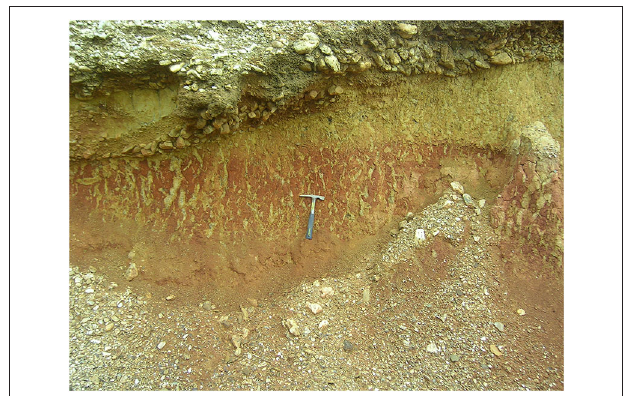
FIGURE 4 | Rhizoliths within pedogenized clay (Mongelli et al., 2015).